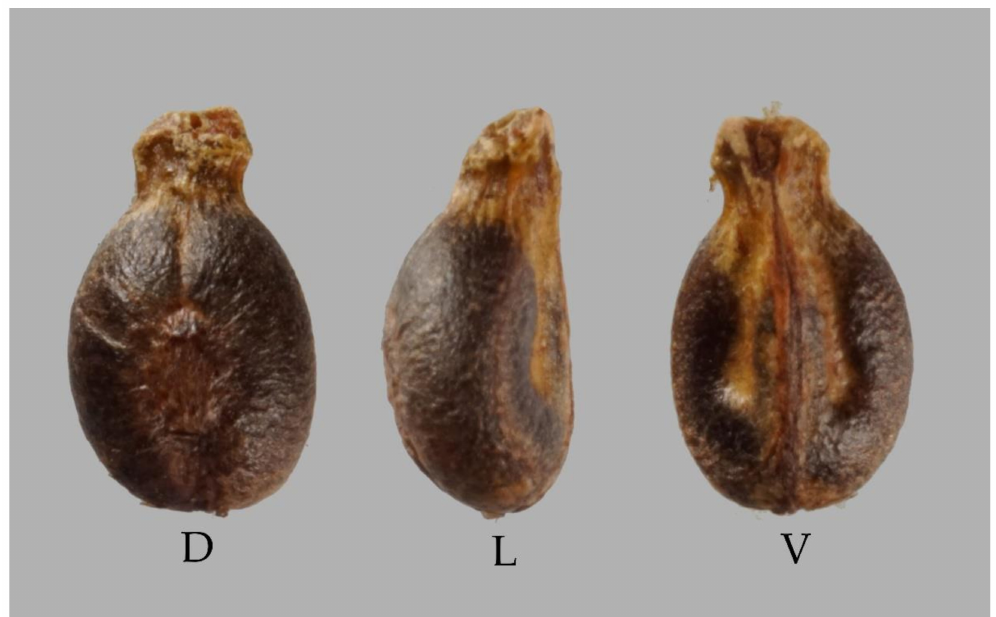
Figure 1. Seeds of V. vinifera ssp. sylvestris in three orientations: dorsal (D), lateral (L) and ventral (V). Ventral views are used in all the images, because the seeds are more stable and the orientation occurs in a plane perpendicular to the line of vision. In the dorsal view, the seed tends to oscillate resting on the central rib and a flank, resulting in more variable sub-lateral